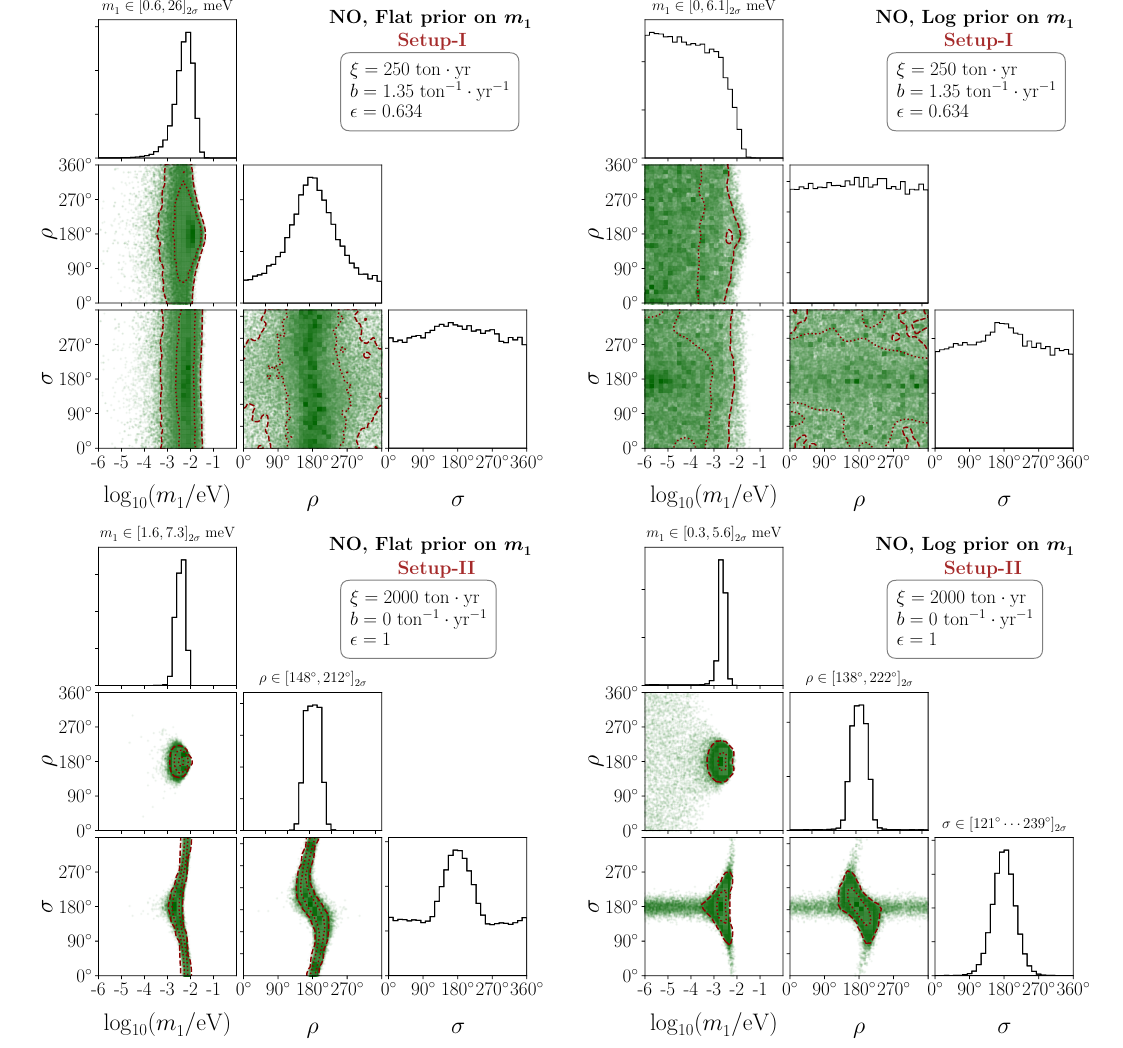
, and the Majorana CP Figure 2 . The posterior distributions of the lightest neutrino mass m 1 phases ρ and σ in assumption of the null signal in future 0 νββ -decay experiments. Their individual posteriors as well as their correlations have been shown. The regions formed by the green points stand for the correlations of these three parameters. The dashed (dotted) red contours surround the 2 σ ( 1 σ ) regions of highest posterior densities. The histograms stand for the posteriors of each individual parameters of m , ρ and σ with proper 1